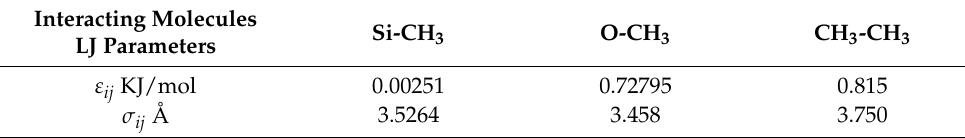
Table 2. Lennard–Jones parameters for ethane–ZSM-22 interactions. Interacting